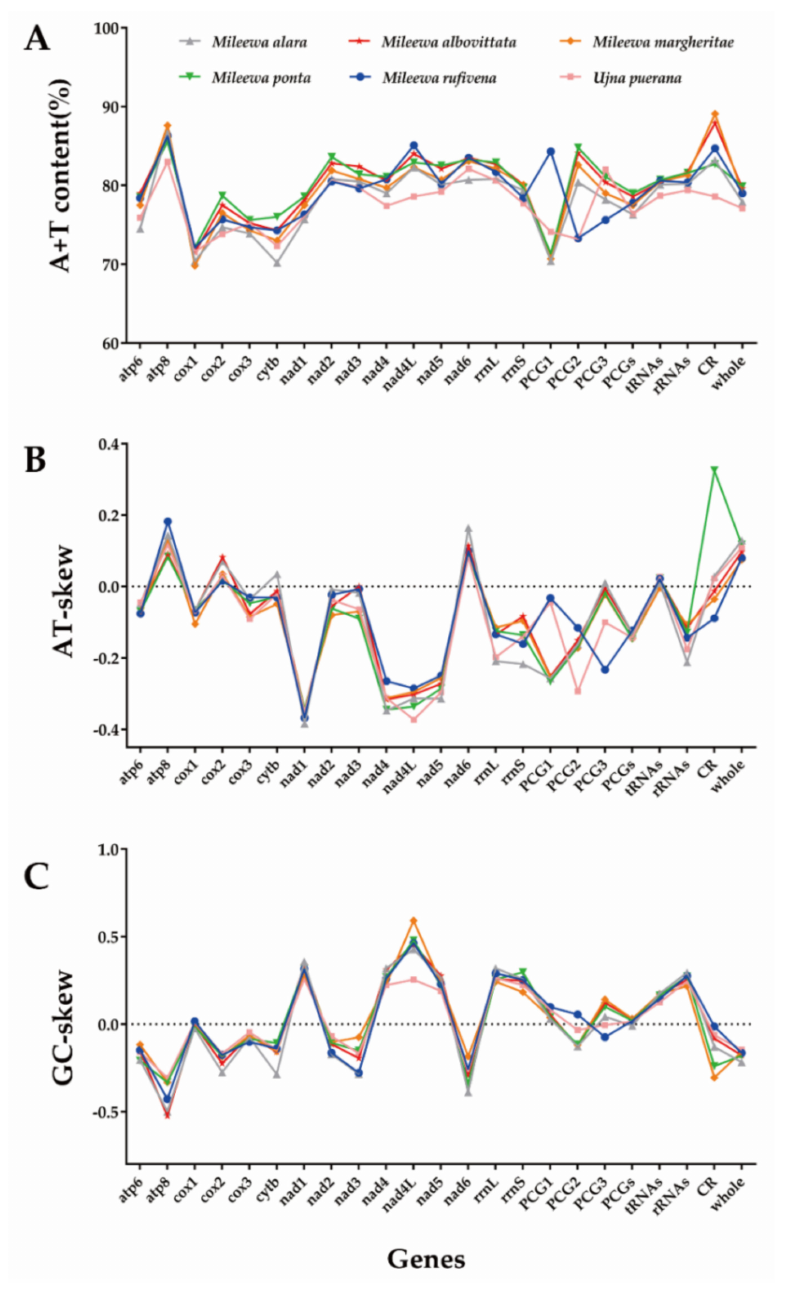
Figure 2. Comparison of the A + T contents, nucleotide skewness of six species of Mileewinae. ( A ) A + T content, ( B ) AT-skew and ( C ) GC-skew. Except for the termination codon, the total number of codons is 3645 ( M. rufivena ) and 3652 ( U. puerana ). The three most abundant amino acids are Leu ( M. rufivena : 13.46%, U. puerana : 14.14%), Ile (11.59%, 11.59%) and Ser (9.77%, 10.14%). Arg (1.38%, 1.35%), Glu (1.54%, 1.57%) and Cys (1.68%, 1.76%) are the least used in the two Mileewinae mitogenomes. The relative synonymous codon usage (RSCU) of mitogenomes of the six Mileewinae species is shown in Figure 3. The six amino acid codons in the largest numbers are AUU (Ile), UUA (Leu2), UUU (Phe), AUA (Met), AAU (Asn) and UAU (Tyr), which are all composed of A and U. Additionally, the three positions of each amino acid codon are more likely to use A/T than G/C (Figure 2A), reflecting the nucleotide A + T bias in the PCGs of Cicadellidae. Among 62 available codons, M. rufivena loses the codon Thr (ACG) and Ala (GCG) is missing in U. puerana